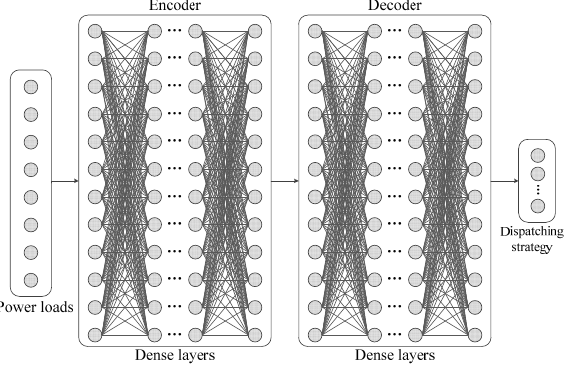
Figure 5. A simple example of MLP.